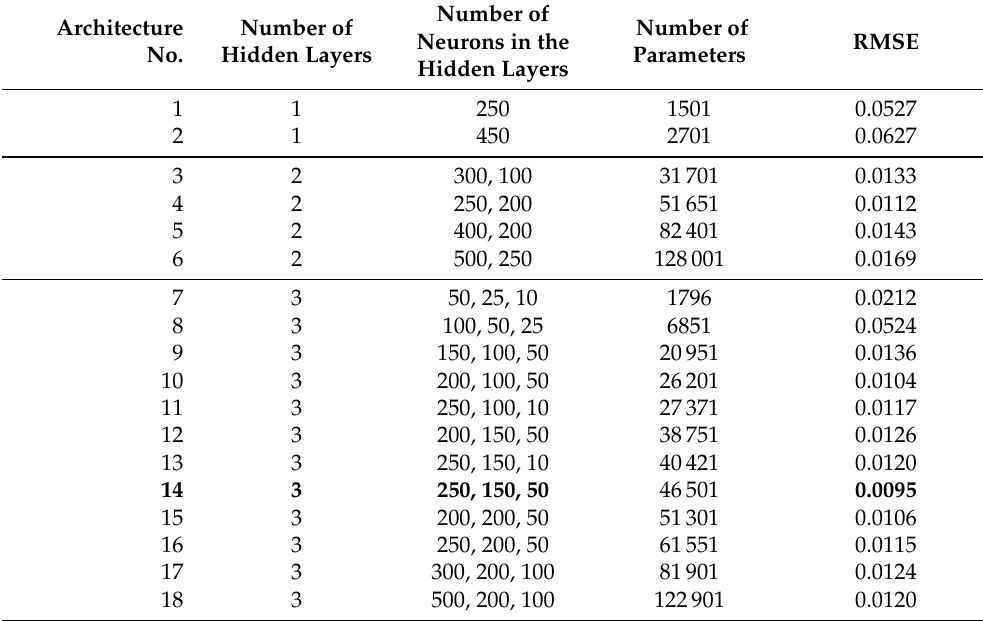
Table 2. Root Mean Squared Error (RMSE) of different architectures. The architecture with the lowest RMSE is marked in bold font. Number of Number of Architecture Number of Neurons in the Parameters No. Hidden Layers Hidden Layers